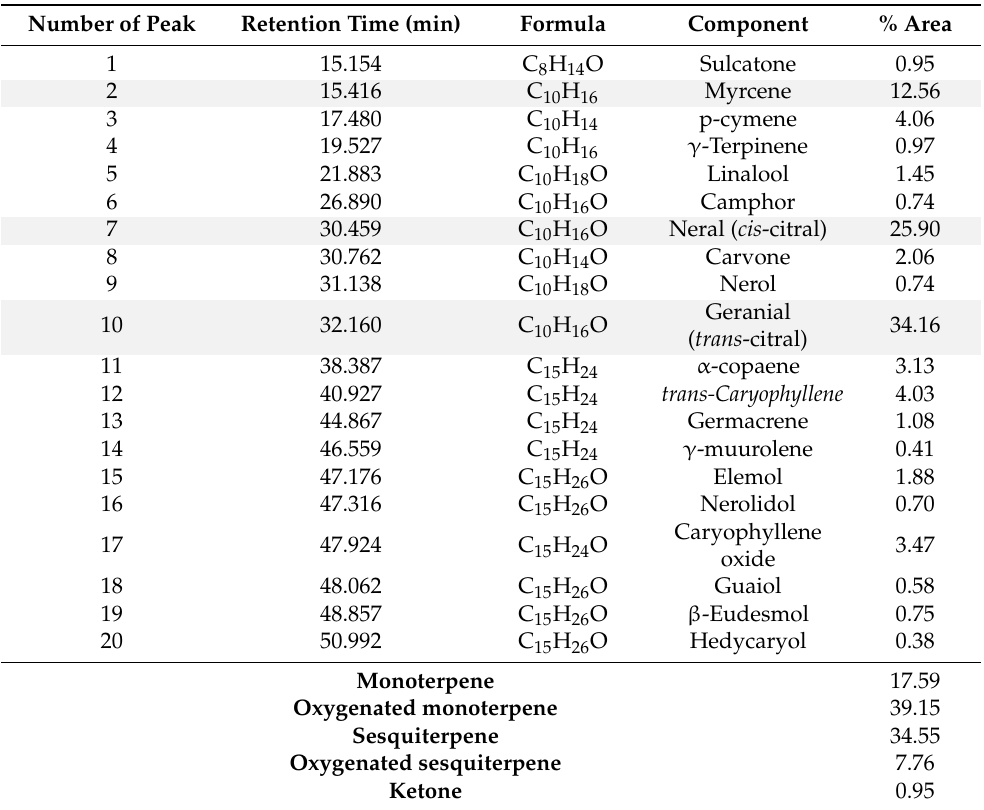
Table 1. Chemical components of LaEO I identified by gas chromatography-mass spectrometry (GC/MS).